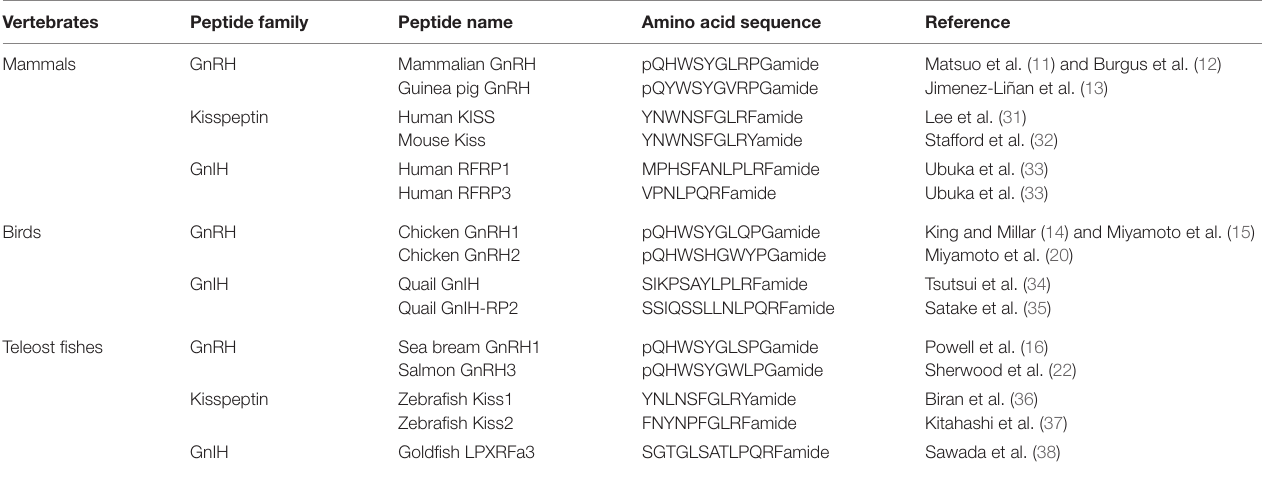
tABLe 1 | representative amino acid sequences of GnrH, kisspeptin, and GniH peptide families in mammals, birds, and teleost fishes.